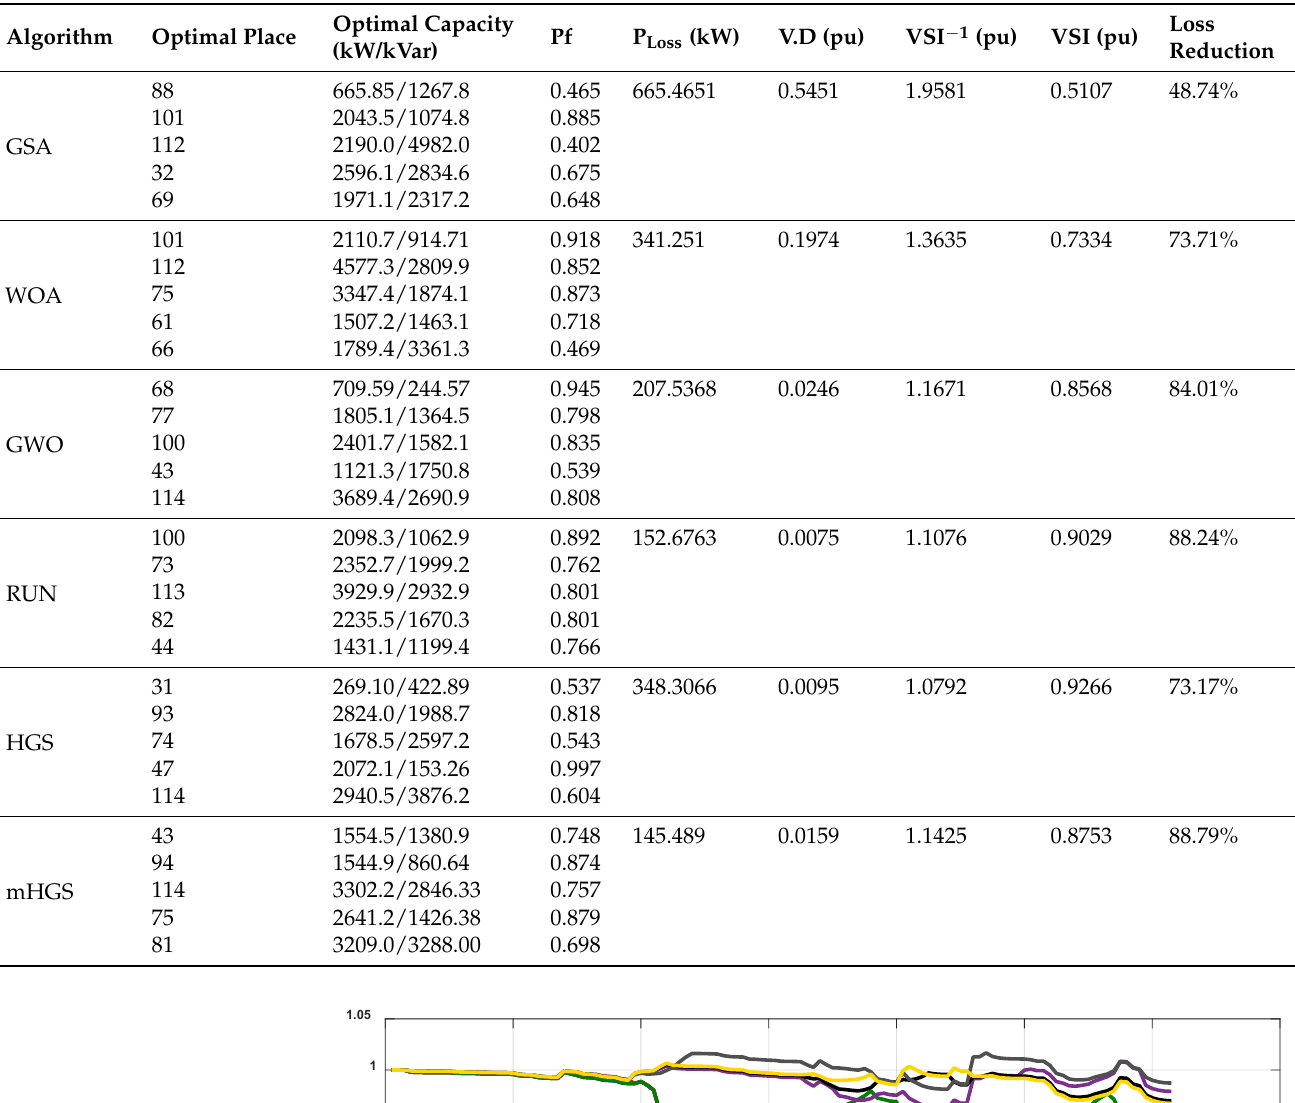
Table 8. The optimal results obtained via different optimizers applied to the IEEE 119-bus.